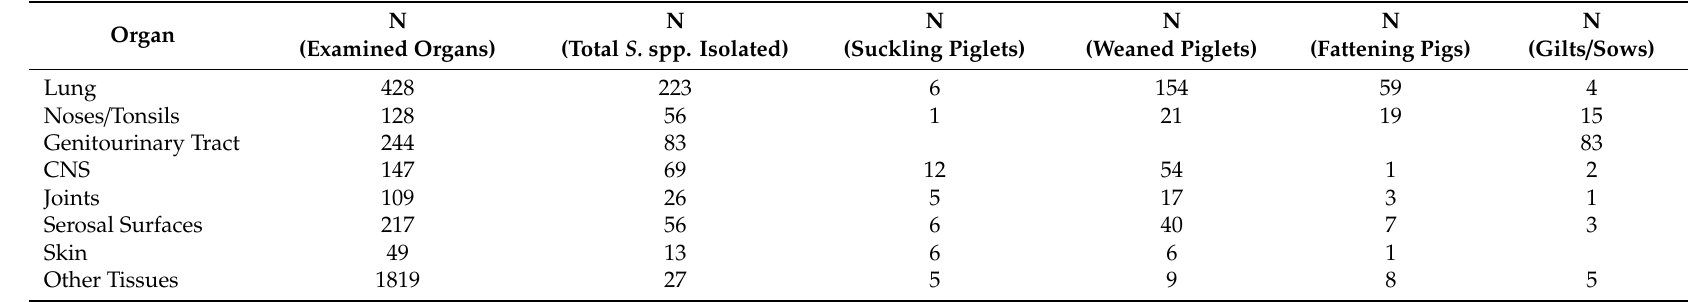
Table 4. Total number of examined organ samples from which S. spp. could be isolated and number of recovered S . spp. from every age group. N Organ (Examined Organs)